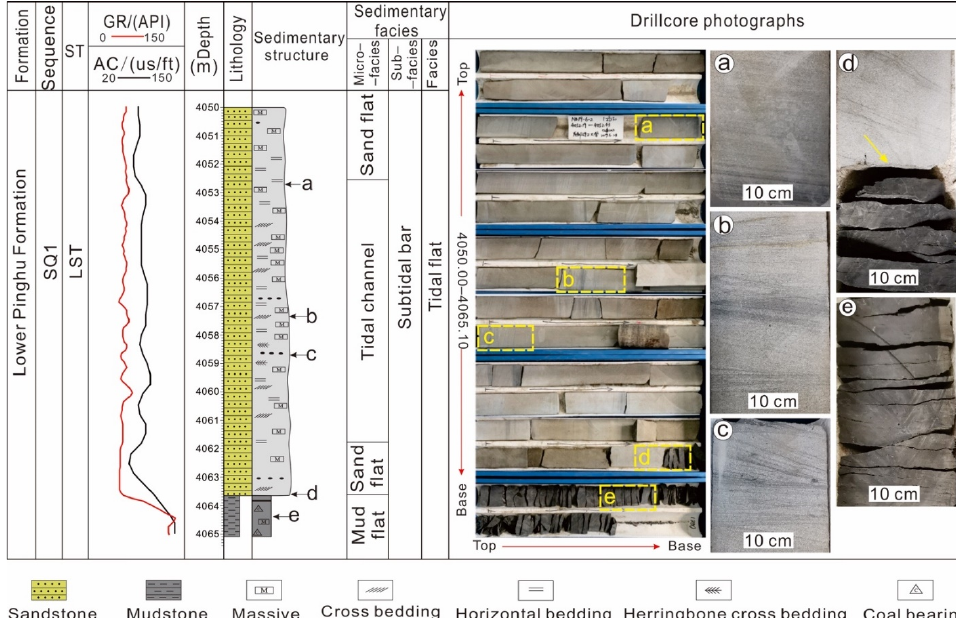
Figure 10. Well log, drill core, and facies interpretations for borehole W-3 from 4065–4050 m in the Xihu Depression. ( a ) 4052.68 m, grey-white fine sandstone with developed mainly parallel bedding with organic matter enriched within laminae; ( b ) 4057.26 m, grey fine sandstone with oblique bedding; ( c ) 4058.72 m, developed herringbone crossbedding; ( d ) 4063.48 m, the scouring surface and contact surface of grey sandstone and black mudstone; ( e ) 4064.36 m, black laminated mudstone with organic granules.